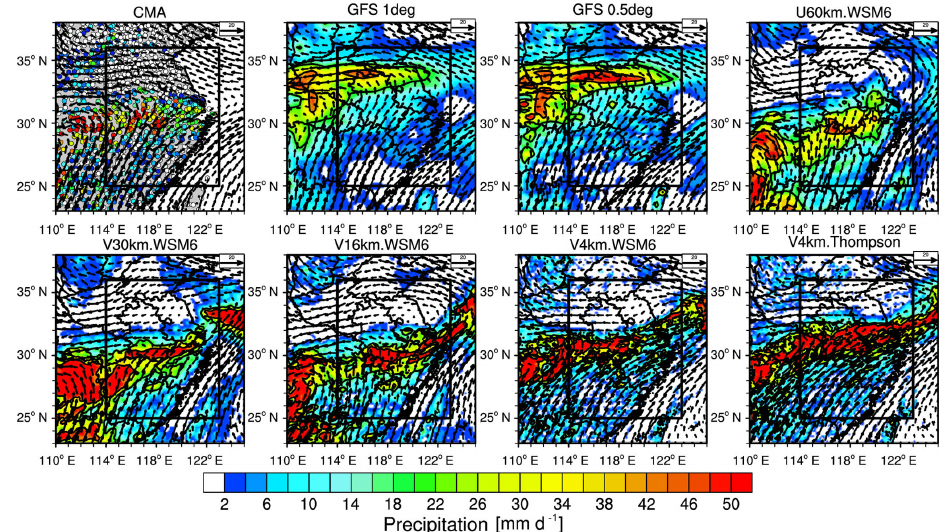
Figure 6. Spatial distributions of precipitation and wind fields at 850hPa averaged during the event from the MPAS simulations at resolutions of 60, 30, 16, and 4km. The observed mean precipitation from the CMA stations and the wind fields from the ERA5 reanalysis are shown as well. The black contour lines represent precipitation larger than 20mmd − 1 . The black box denotes the region of East China (25–36 ◦ N, 114–123 ◦ E) for the analysis in the following. For comparison, the GFS forecasts at 1 and 0.5 ◦ resolutions are also